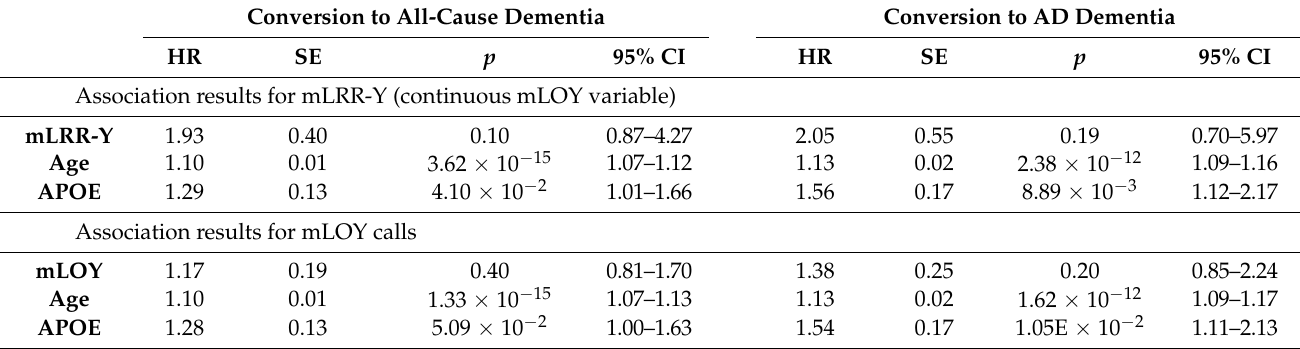
Figure 2. Association of mLOY phenotypes with risk of conversion to dementia and AD dementia over time for men with MCI in the GR@ACE-DEGESCO cohort. Kaplan–Meier plots showing survival time in years for conversion to ( a ) dementia or ( b ) AD for prospective MCI men with LOY (blue) or without LOY (red) in the GR@ACE-DEGESCO cohort. Table 2. Cox proportional-hazards model results for conversion of men with MCI to all-cause dementia or AD dementia. We adjusted the models by age at sampling and APOE genotype. CI, confidence interval.